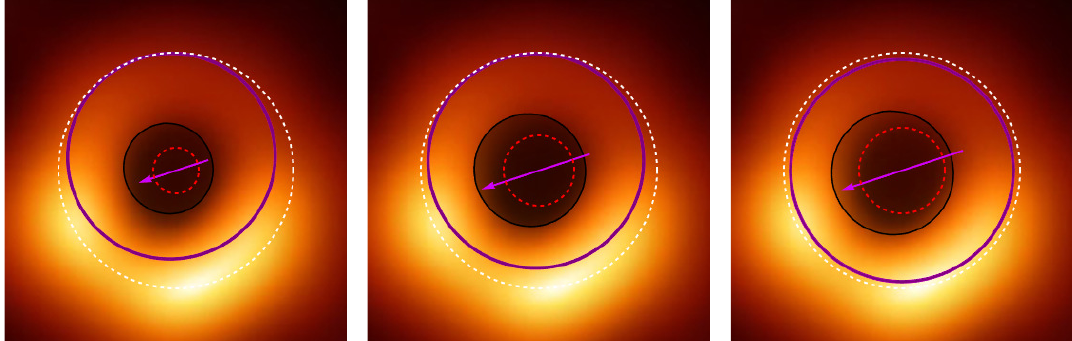
Figure 12. Superposition of the M87* image, obtained by the Event Horizon Telescope (EHT), with both the contours af classical black hole shadows (purple closed curves) and the event horizon silhouettes (dark regions) for di ff erent values of the black hole spin, a = 0.998 (left panel), a = 0.75 (central panel) and a = 0 (right panel). Magenta arrows—a black hole rotation axis. Small dashed ring—a black hole event horizon projection on the celestial sphere in the imaginary Euclidean space (in the absence of gravity). The modeled dark spot on the right panel in the a = 0 case produces an excessively large dark spot in comparison with one on the EHT image. At the same time, a size of the dark spot on the EHT image agrees with a corresponding size of the dark event horizon silhouette in a thin accretion disk model in the case of either the high (left panel) or moderate (central panel) value of the black hole spin, a (cid:38)